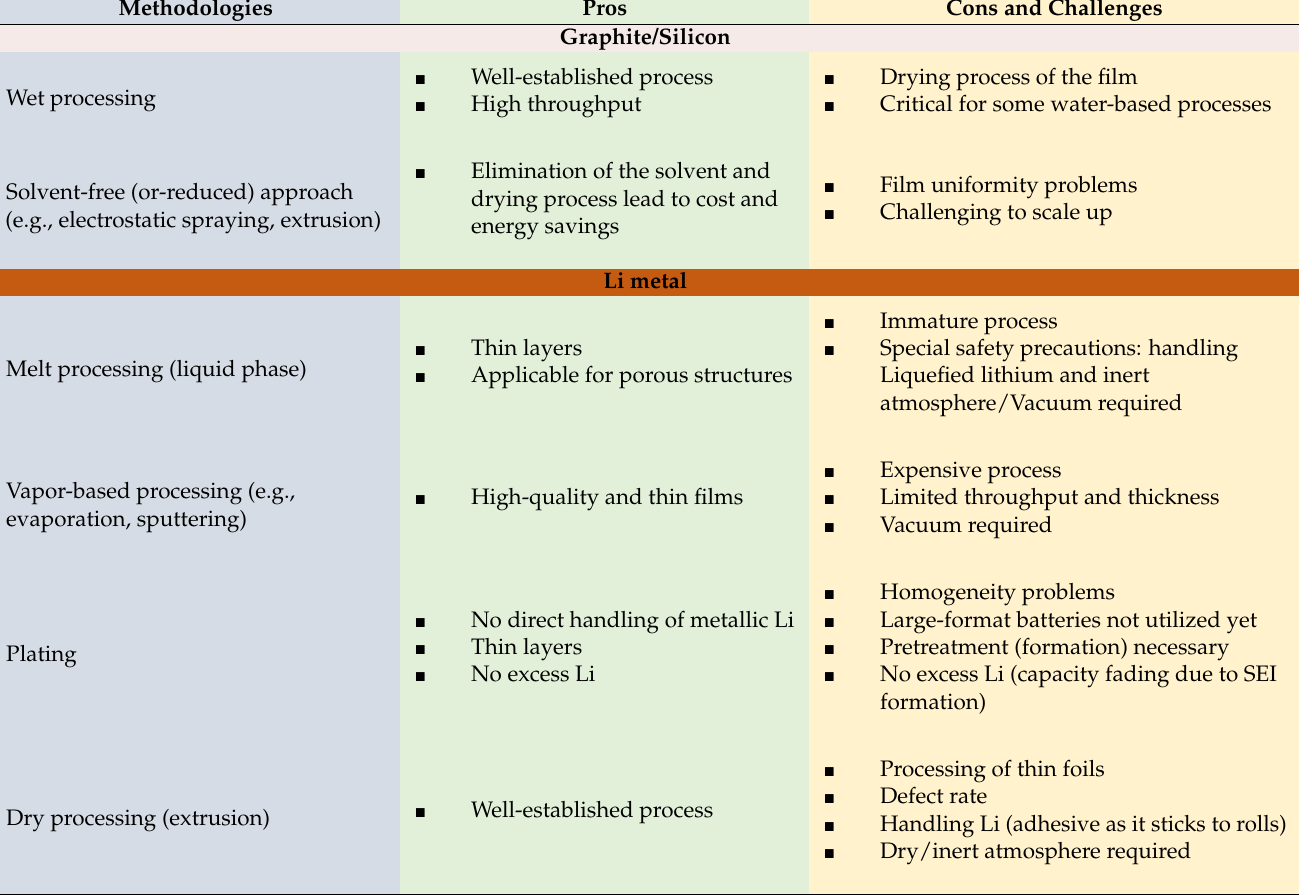
Table 2. Processing routes for anode materials, including their advantages and